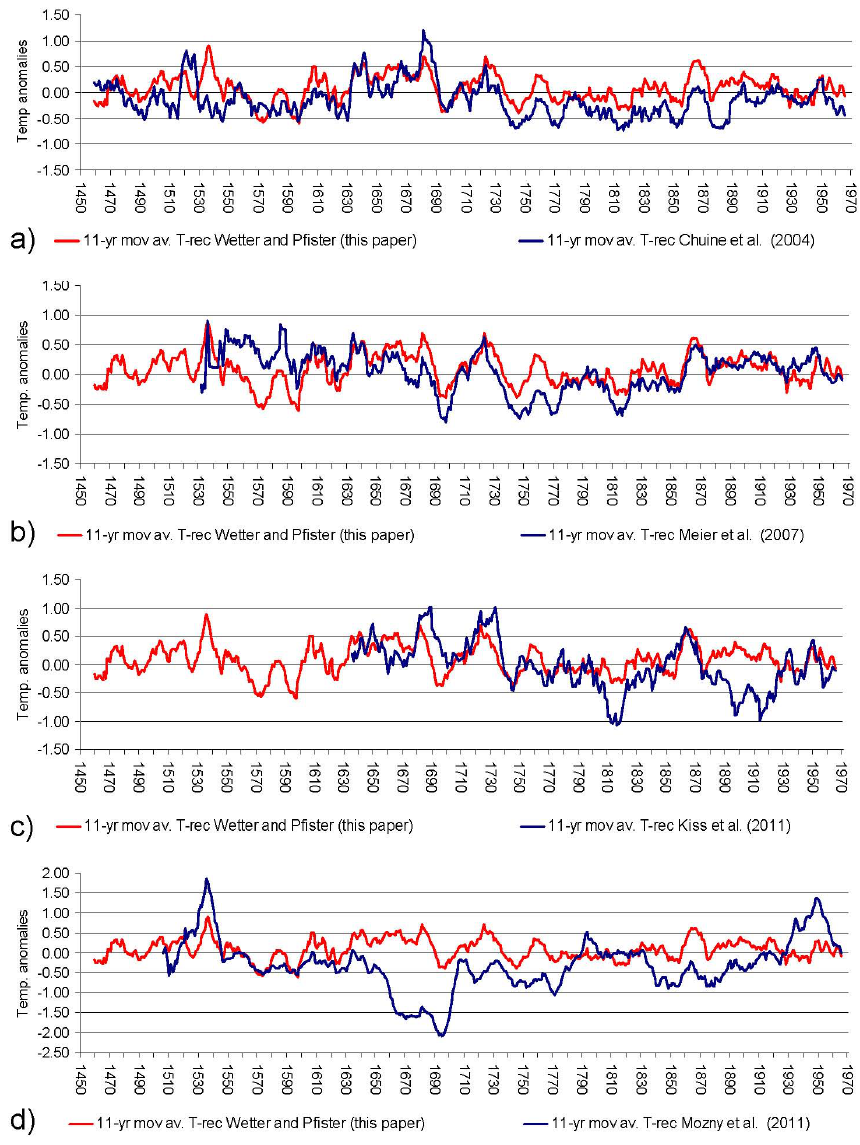
Fig. 9. (a) 11-yr moving averages of Basel WGHD (red) and Burgundy GHD reconstructed temperature anomalies. (b) 11-yr moving averages of Basel WGHD (red) and Swiss Plateau GHD reconstructed temperature anomalies. (c) 11-yr moving averages of Basel WGHD (red) and Hungary temperature anomalies reconstructed temperature anomalies. (d) 11-yr moving averages of Basel WGHD (red) and Czech Republic WGHD reconstructed temperature